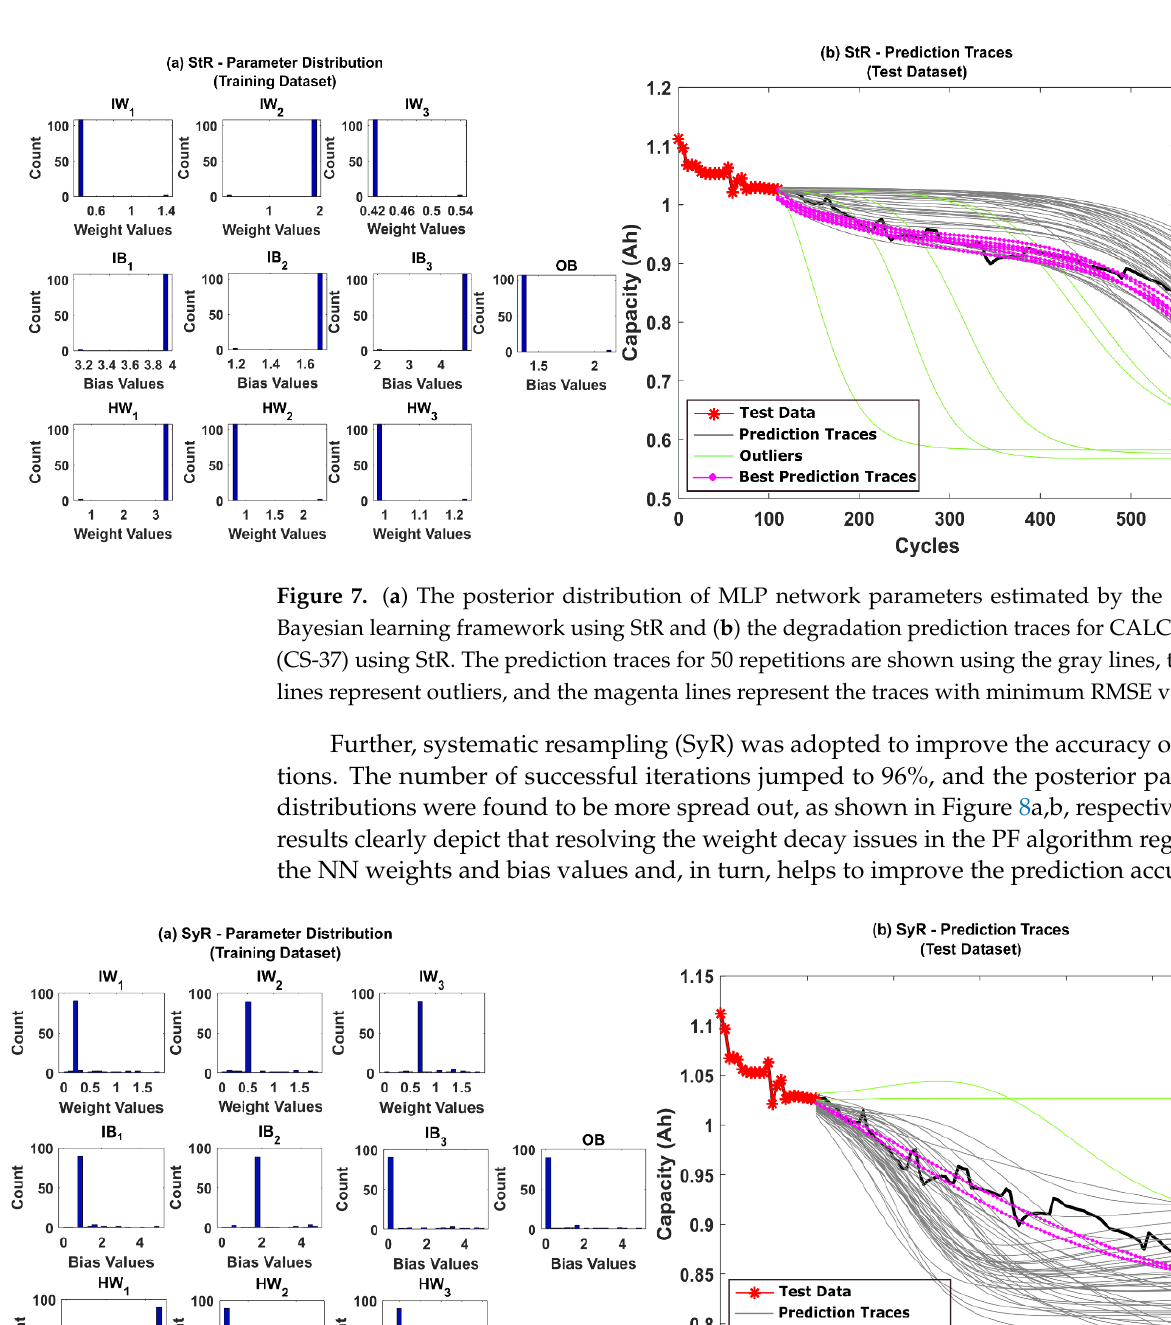
Figure 6. ( a ) The posterior distribution of MLP network parameters estimated by the adaptive Bayesian learning framework using MR and ( b ) the degradation prediction traces for CALCE bat- tery (CS-37) using MR. The prediction traces for 50 repetitions are shown using the gray lines, the green lines represent outliers, and the magenta lines represent the traces with minimum RMSE val- ues.